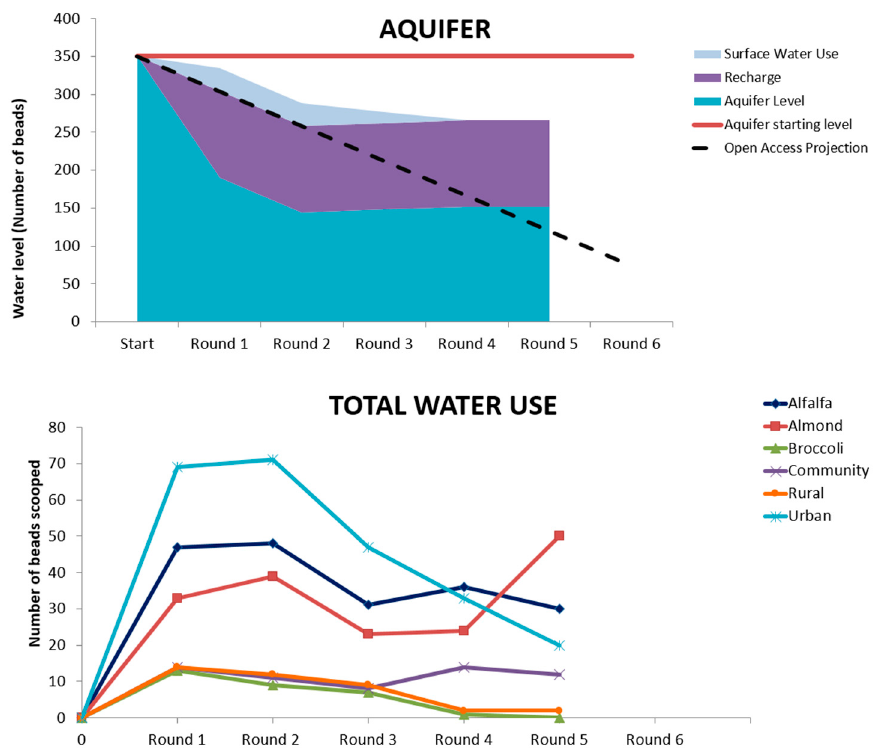
Figure 1. The game uses a spreadsheet, which is used to provide real-time feedback to game players about the state of the aquifer and total water use (shown), as well as charts showing which players have obtained enough water to meet their needs, their earnings, and their bank accounts.